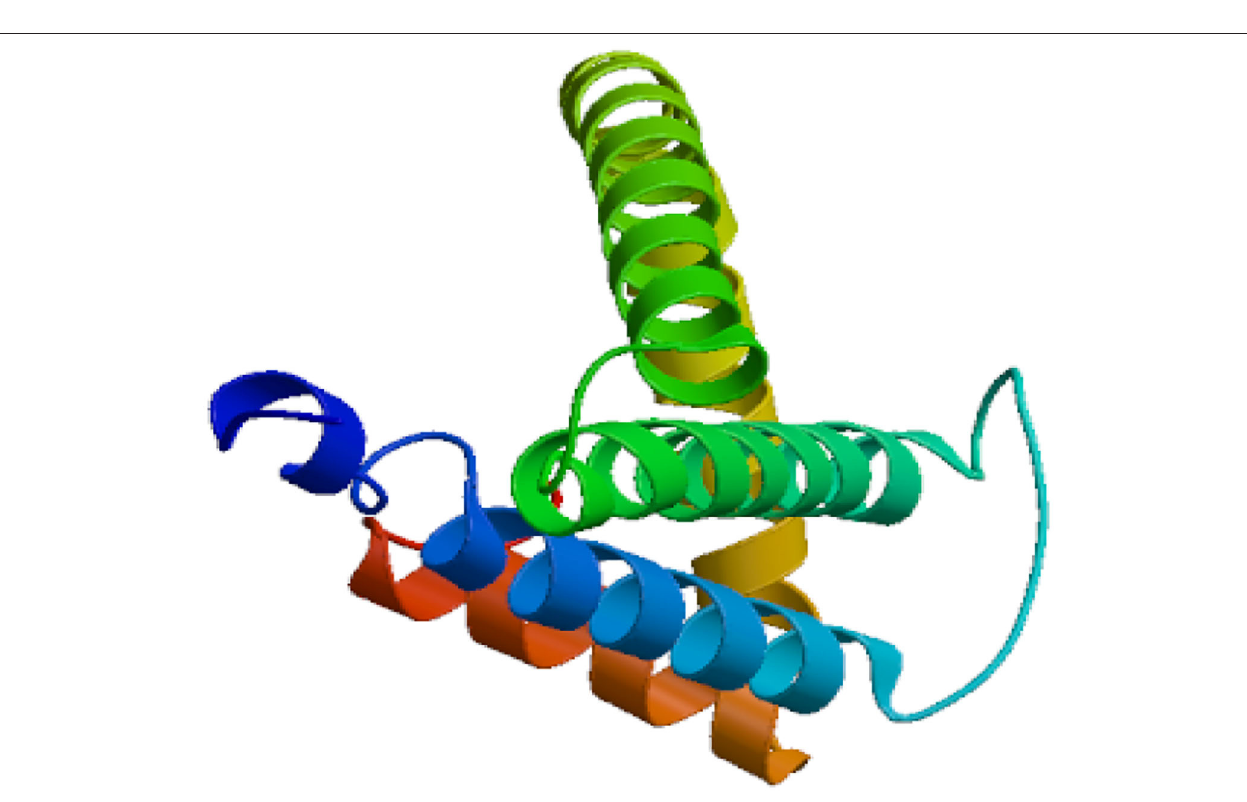
FIGURE 2 | Predicted secondary and three-dimensional structure of the Eg-TSP11